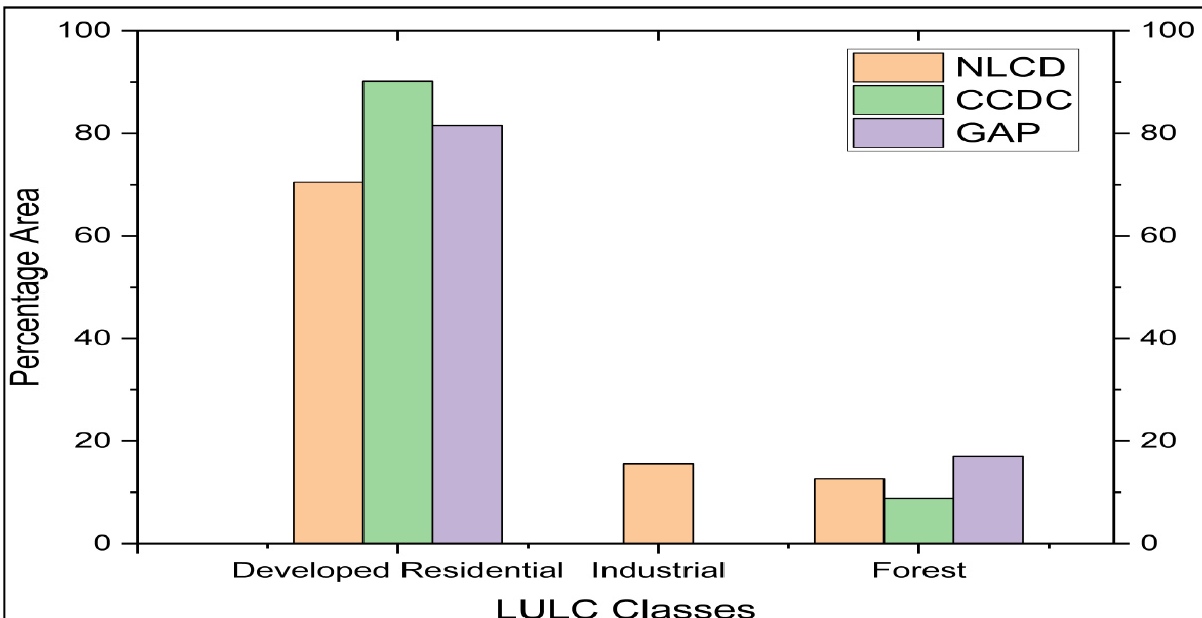
Figure 4. Distribution of land use and land cover classes for the year 2011 as a percentage of total watershed area for three sources.